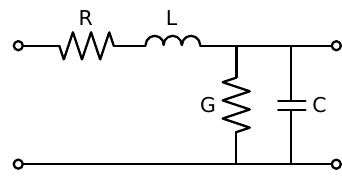
Figure 3. Infinitesimal transmission